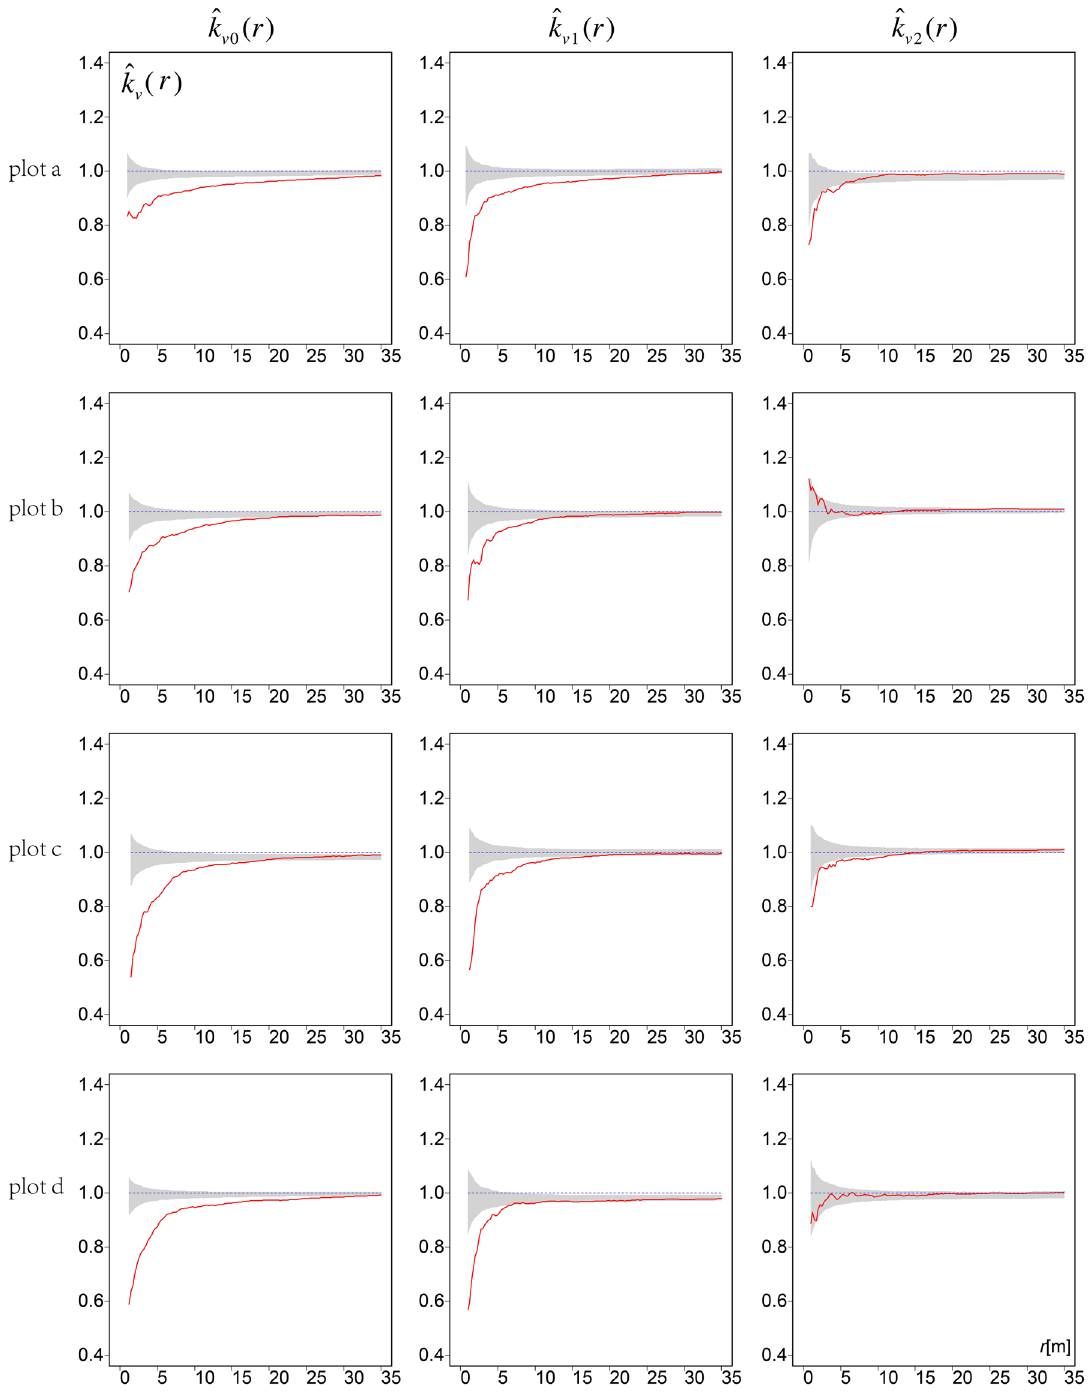
Figure 4. Mark mingling functions ( ˆ k r ( ) ) for trees of different size classes. Solid curves: observed mark v mingling functions. Envelopes (grey areas) were constructed using the 2.5% and 97.5% quantiles of 1,000 Monte Carlo simulations. Heading subscripts 0, 1, and 2 denote three dbh size classes (small, intermediate, and large, respectively). Note: Curves lying below the simulation envelopes indicate aggregation of similar tree species. Curves lying above the simulation envelopes indicate aggregations of different tree species. The distributions of tree species are random if the curves lie within the simulation